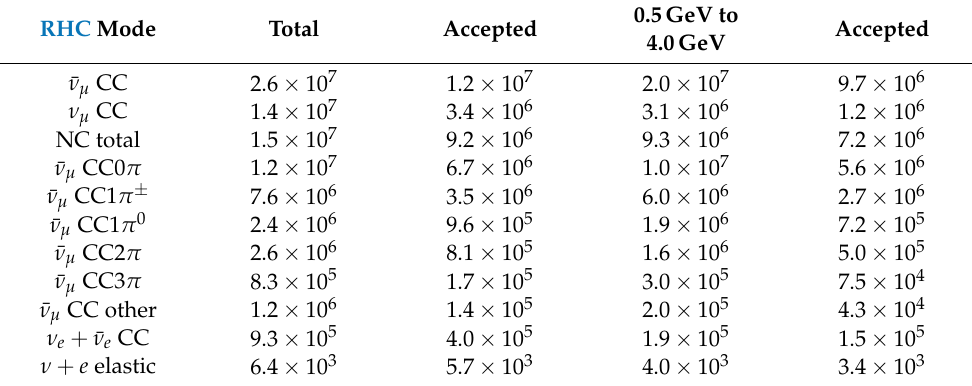
Table 11. RHC Event rates in ND-LAr (per year as defined in the text). Accepted is defined as the µ is either contained or matched to the multi-purpose detector (MPD), and the hadronic shower is contained (<30MeV in the outermost 30cm of the